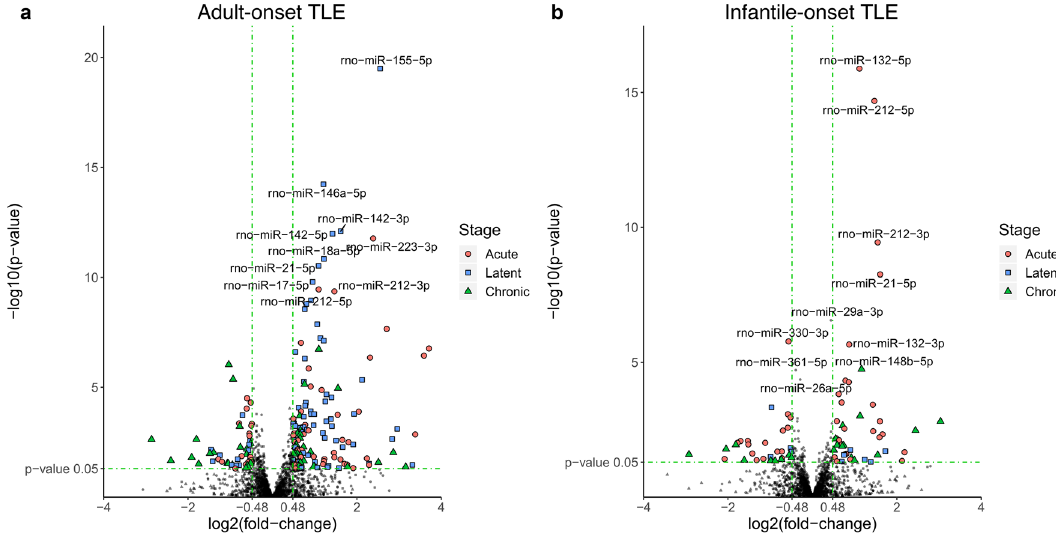
Figure 2. Expression changes of all miRNAs detected in adult and infantile-onset of epileptogenesis. The volcano plots display changes in miRNA expression after SE induced in adulthood ( a ) and infancy ( b ). Scattered points represent individual miRNAs identified by DESeq2. The x-axis specifies the log2 fold-changes (log2(FC)), and the y-axis specifies the negative logarithm to the base 10 of the p -values. Green vertical and horizontal dashed lines reflect the filtering criteria (log2(FC) = ± 0.48 and p -value = 0.05). log2(FC) > + 0.48 indicates miRNA levels increased by > 1.4 times in SE-treated rats, whereas log2(FC) < − 0.48 indicates miRNA levels reduced by > 1.4 times in SE-treated rats. miRNAs significantly dysregulated in the acute stage of epilepsy are depicted by red circle points. miRNAs dysregulated in the latent stage are represented as blue square points, and in the chronic stage, they are represented as green triangle points. Non-significant miRNAs are depicted in black. Ten miRNAs with the highest fold-change difference between SE and control animals in adult and infantile-onset group respectively are